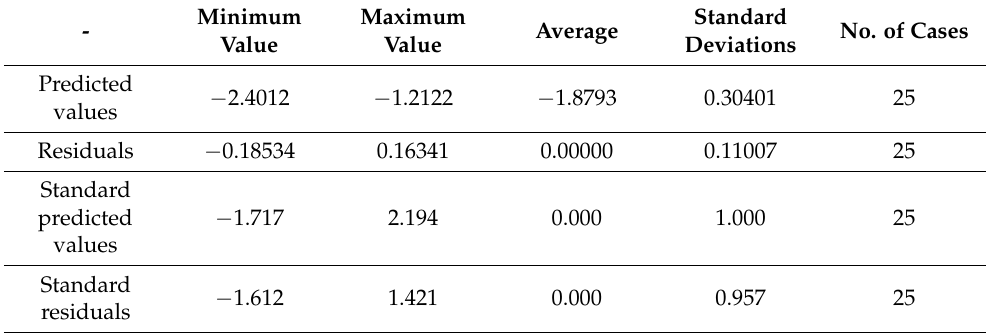
Table 7. Residual statistics.